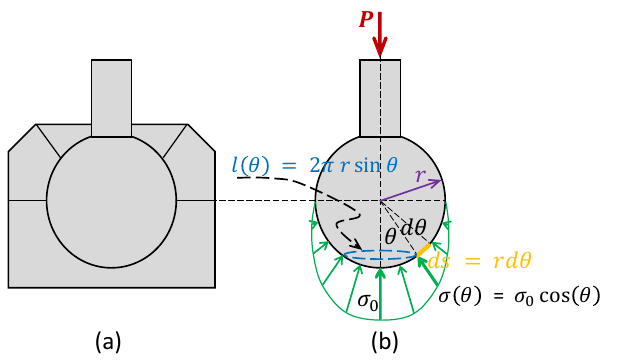
Figure 3. Pressure distribution in the ball joint of the isolator base. ( a ) Ball joint inside its bracket at the base of the isolator, ( b ) free-body diagram (F.B.D.) of the ball joint.